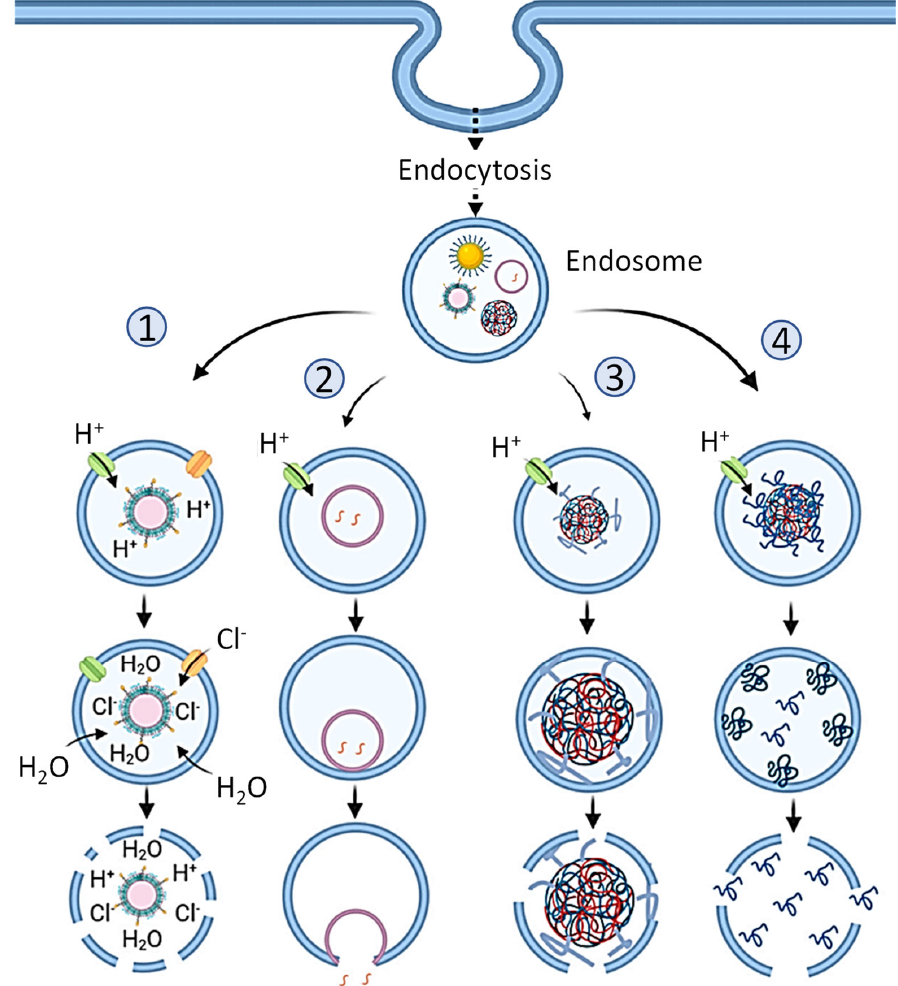
Figure 10. Four main types of endosomal escape mechanisms. After entering a cell by endocytosis, nanoparticles with encapsulated content are located inside endosomes—vesicle budded from the cellular plasma membrane. Four main possible mechanisms of disrupting the nanoparticles and es ‐